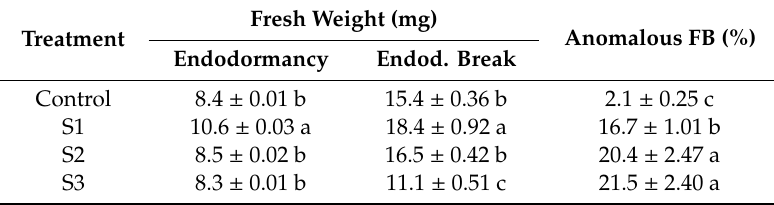
Table 2. Size of flower buds (fresh weight, mg), percentage of pre-flowering anomalies of flower buds (FB), and flowering intensity score (1 = low; 2 = medium; 3 = abundant) recorded in ‘Portici’ apricot cultivar in fully irrigated (control) and imposed drought plants (S1 = June; S2 = July; S3 = October). Data are means ± SD. Di ff erent letters in the same column are significantly di ff erent at p ≤ 0.05.